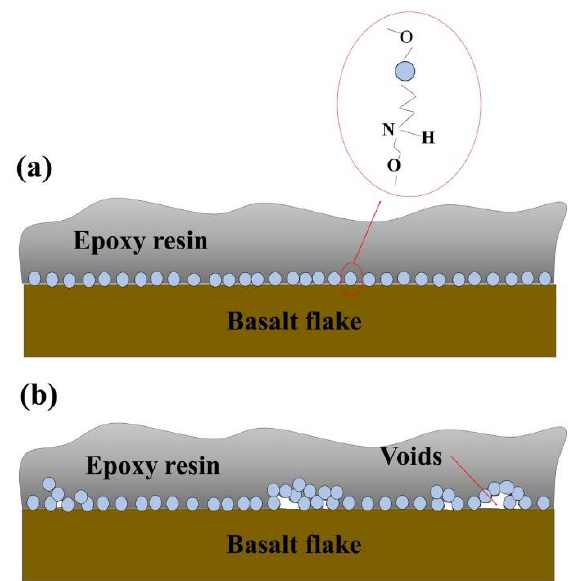
Figure 7. Schematic diagram of the agglomeration and stacking process of nano-SiO 2 microspheres on the surface of the modified BF epoxy resin coating. ( a ) For an appropriate amount of nano-SiO 2 microspheres and ( b ) for an excessive amount of nano-SiO 2 microspheres.